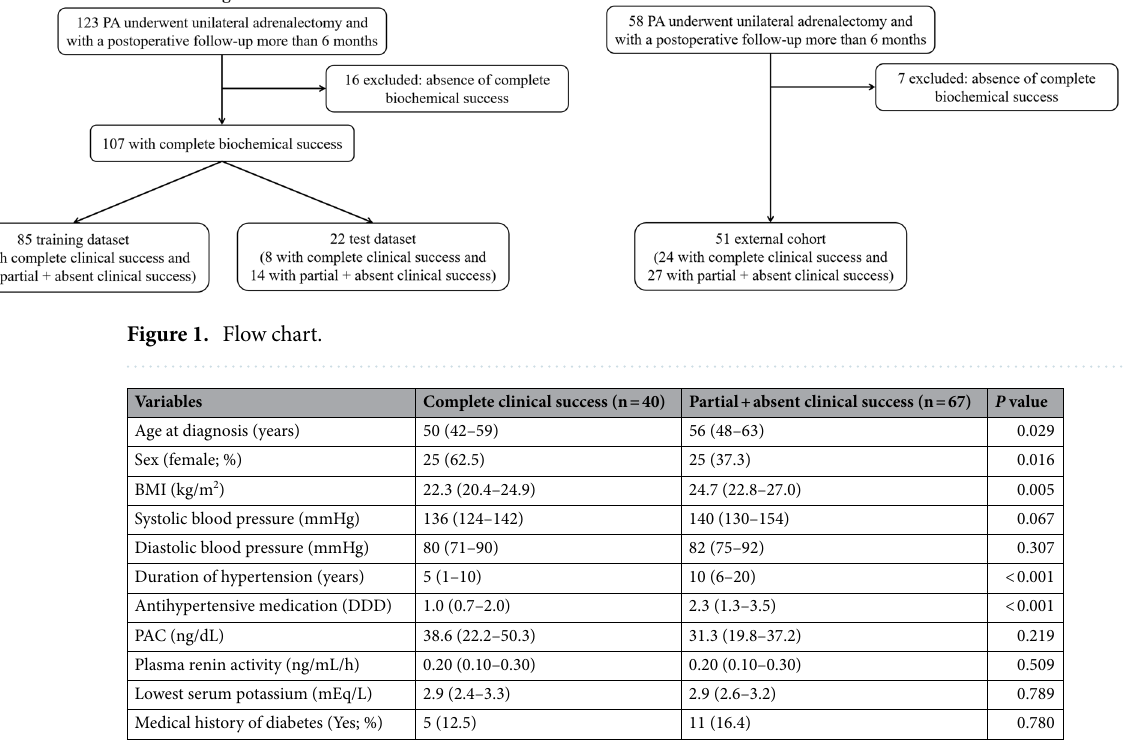
Table 1. Preoperative clinical characteristics of 107 patients with primary aldosteronism in the modeling cohort. Data are expressed as medians with interquartile ranges or numbers with percentages. BMI, body mass index; DDD, defined daily dose; PAC, plasma aldosterone